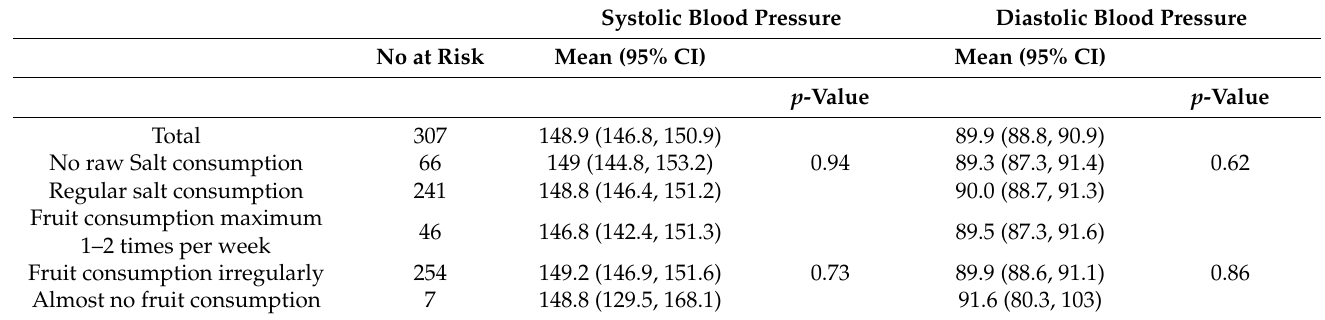
Table 5. Systolic and diastolic blood pressure by raw salt and fruit consumptions. Systolic Blood